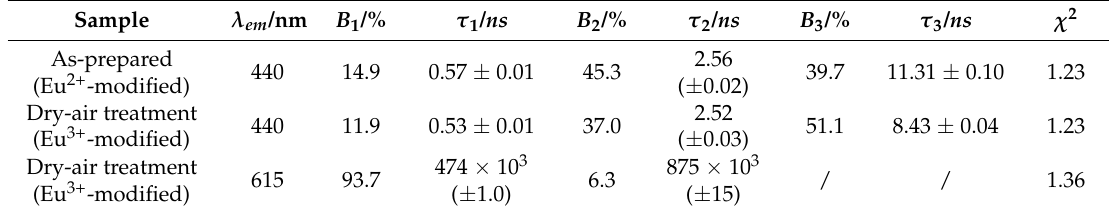
λ em : Emission wavelength at which the decay was monitored; B : Percentage contribution of different decay processes; χ 2 : Wellness of the exponential fit in comparison to raw data. Values in parentheses indicate the standard deviations of the respective decay time.